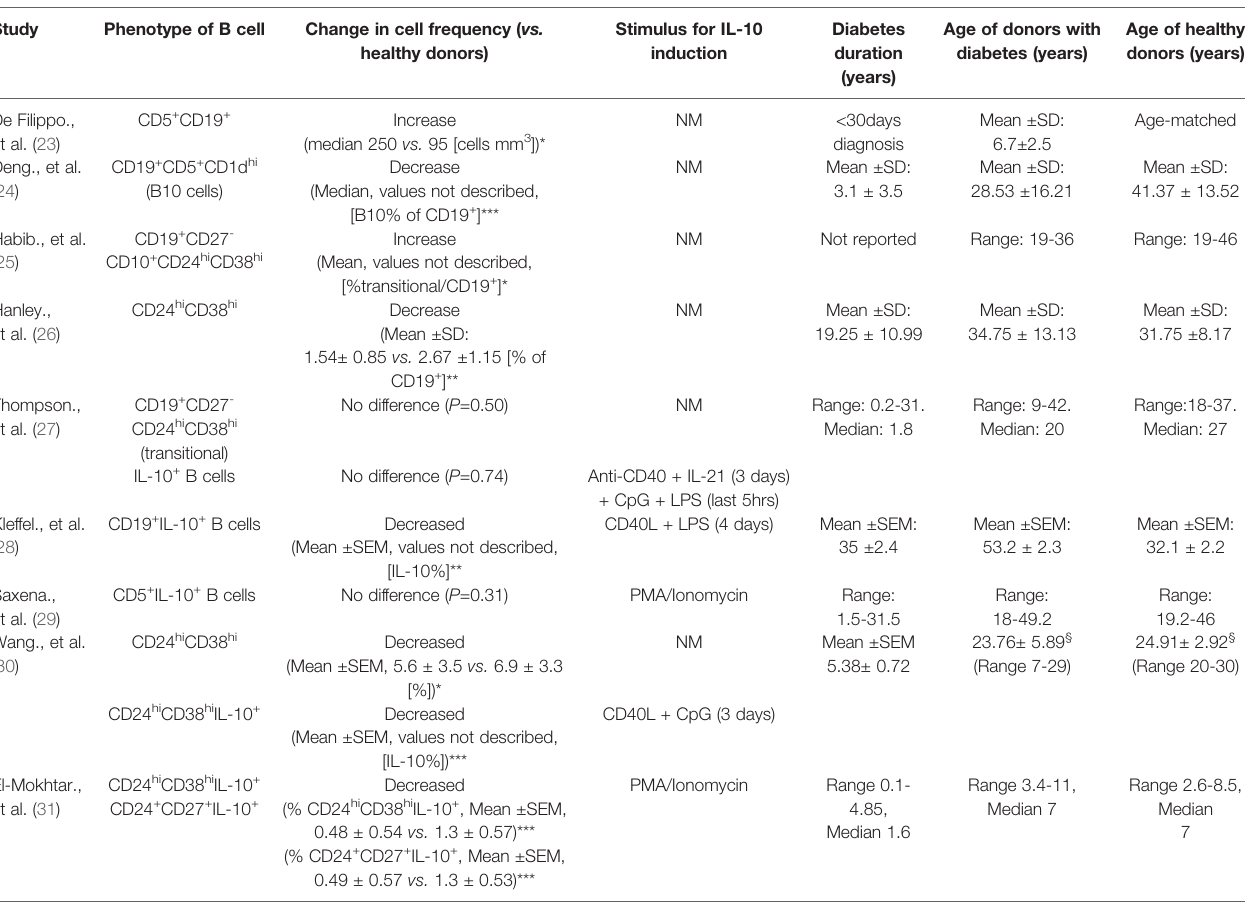
TABLE 1 | Evidence for numerical defects in Bregs in type 1